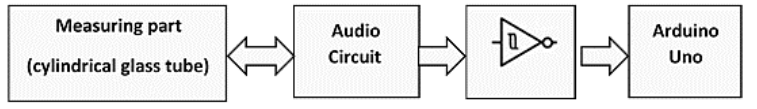
Figure 2. The block diagram of the transducer.